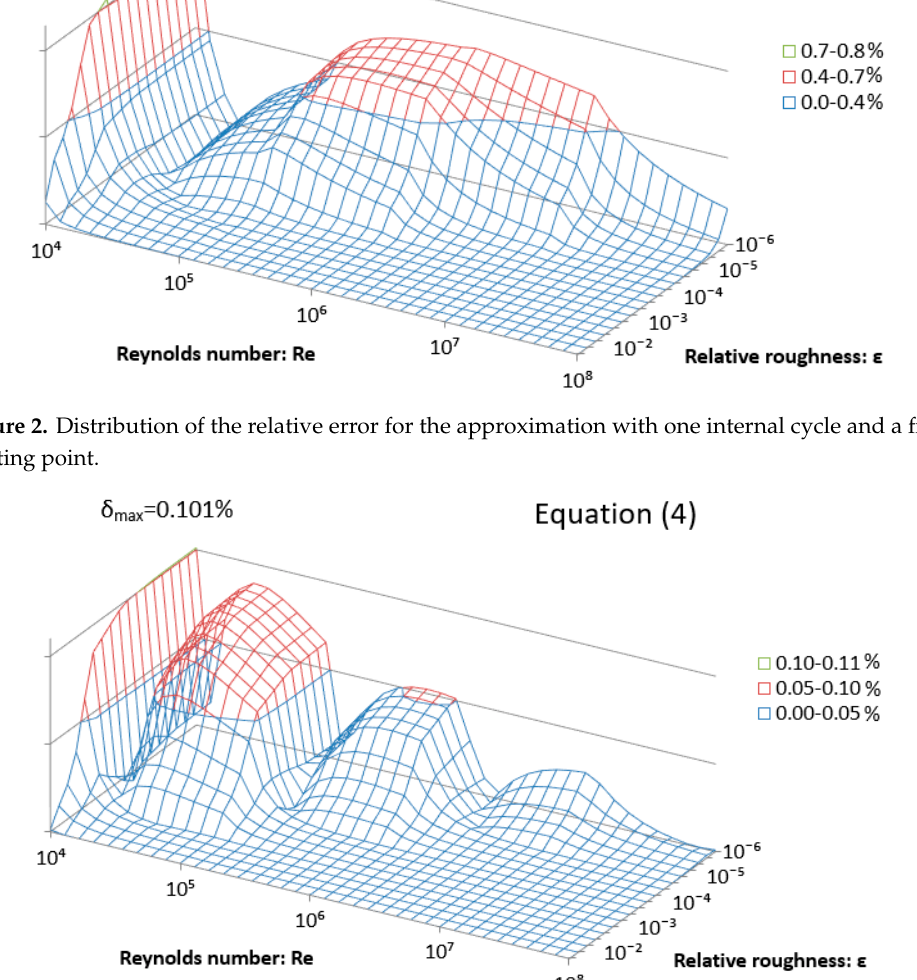
Figure 2. Distribution of the relative error for the approximation with one internal cycle and a fixed starting point.